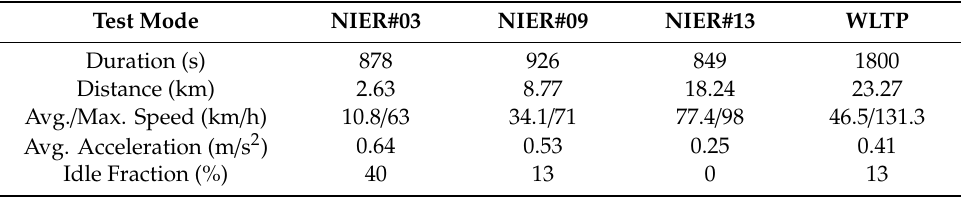
Figure 2. ( a ) Speed profile of test modes. ( b ) Speed and acceleration of test modes. Table 3. Detailed information of test